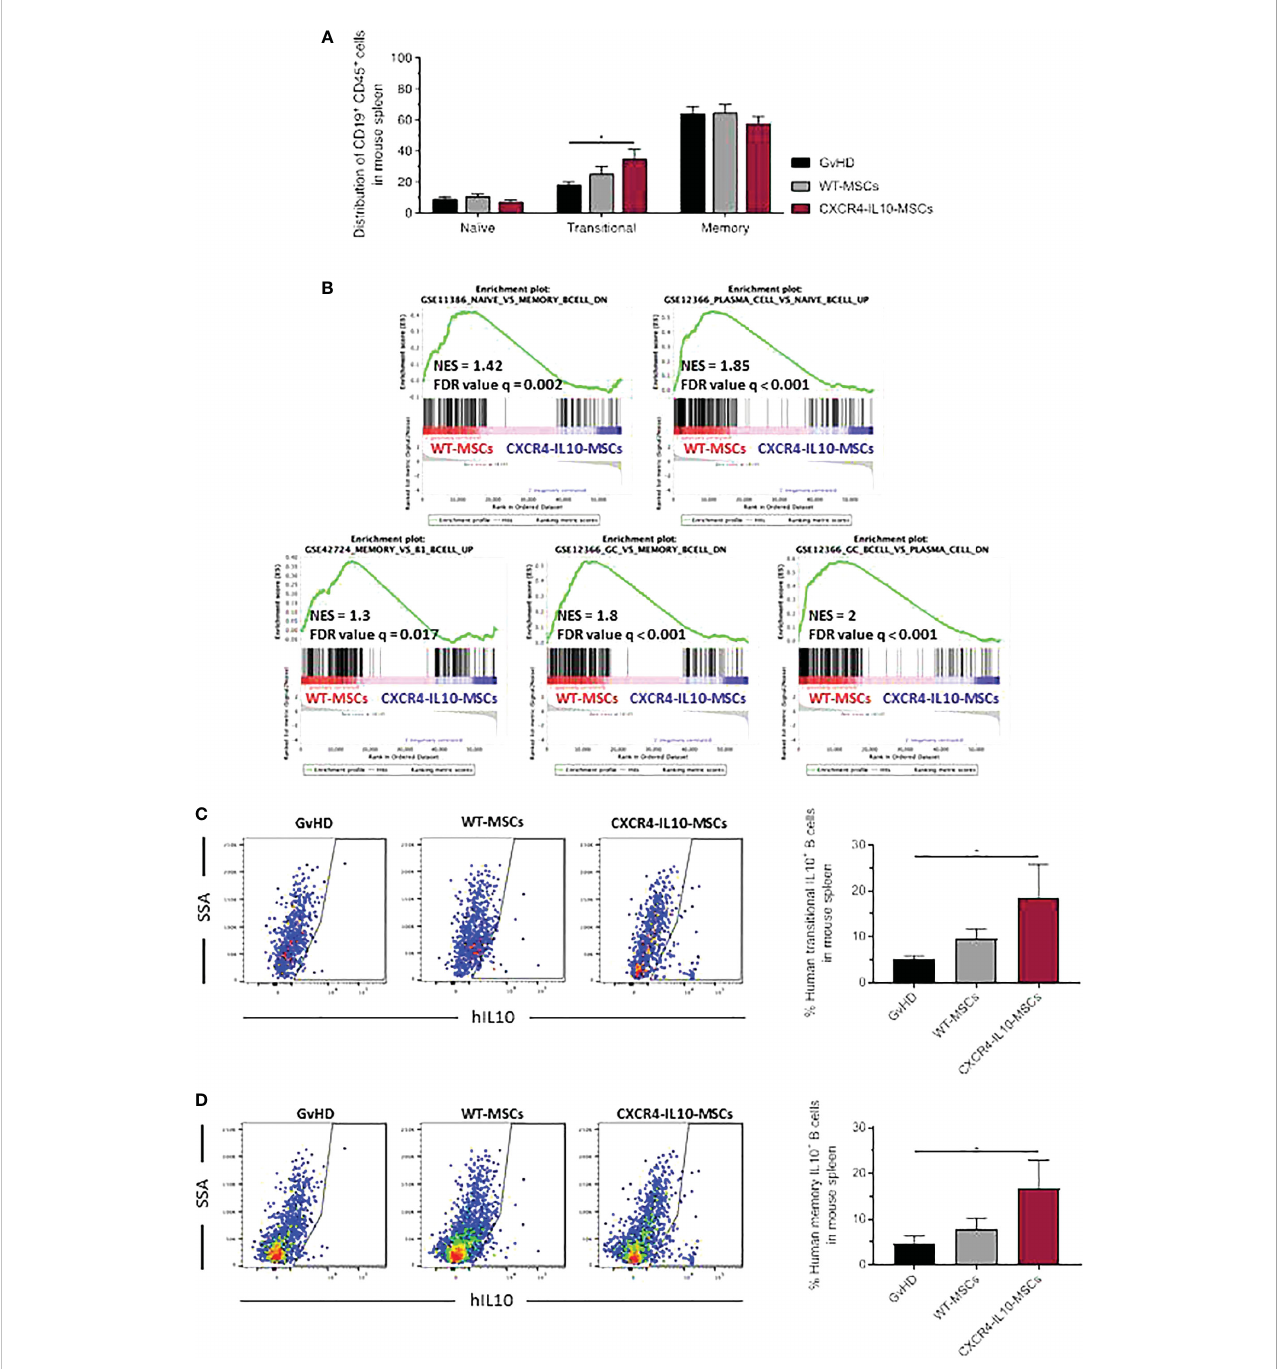
FIGURE 7 Characterization of human CD19 + B-cell subpopulations in the spleen of humanized GvHD recipients treated with WT-MSCs or CXCR4-IL10-MSCs. (A) Flow cytometry phenotype of spleen-in fi ltrating human CD19 + B-cell subpopulations in GvHD recipients treated with WT-MSCs or CXCR4-IL10-MSCs. (B) RNA sequencing of human CD45 + cells isolated from the spleen of WT-MSC-treated mice relative to the CXCR4-IL10-MSC-treated group by gene cluster enrichment (GSEA) of immune signatures corresponding to B cells. (C) Representative fl ow cytometry analysis of each transplanted group and representation of the percentage of IL10 + transitional B cells, analyzed as CD45 + CD19 + CD24 low/+ and CD38 + CD27 +- IL10 + cells. (D) Similar analyses as those conducted in panel C, showing the percentage of IL10 + memory B cells, analyzed as CD45 + CD19 + CD27 + IL10 + cells. Each analysis compares data corresponding to 3 mice per group. NES, Normalized Enrichment Score; FDR, False Discovery Rate. *p <